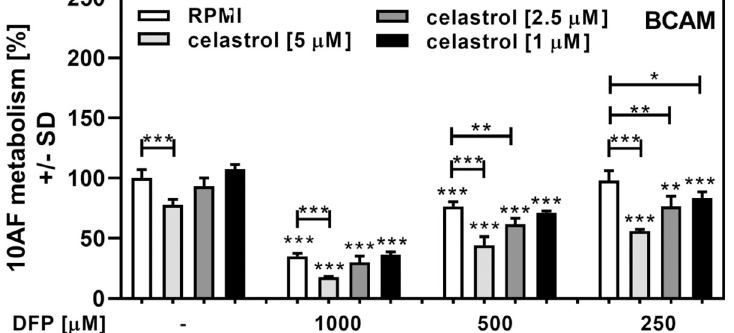
Fig 6. Celastrol sensitizes A . fumigatus for anti-fungal activity of DFP. Forming wildtype A . fumigatus biofilm (10AF) was incubated with 1, 2.5, or 5 μ M celastrol, 0.25–1 mM of DFP, or combinations of these two substances at 37˚C for 24 hour. Fungal metabolism was measured by XTT assay. Statistics: t-Test. Bars without DFP (leftmost group) vs. all other bars with the same celastrol concentration. Other comparisons as indicated by the ends of the brackets. One, two or three asterisks = p � 0.05, p � 0.01 or p � 0.001,